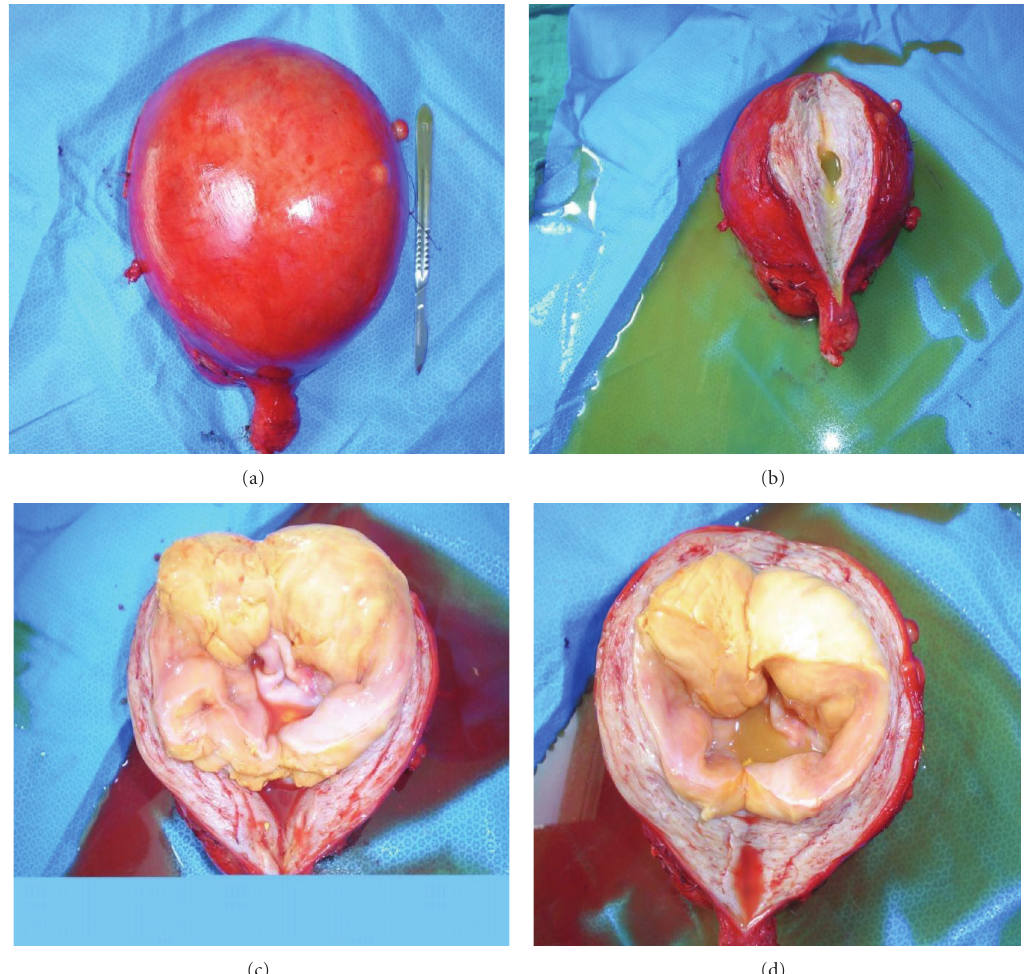
Figure 2: The gross inspection of hysterectomy specimen revealed a well-circumscribed yellow tumor measuring 11/10cm that appears within the myometrial layer that resembled a leiomyoma.